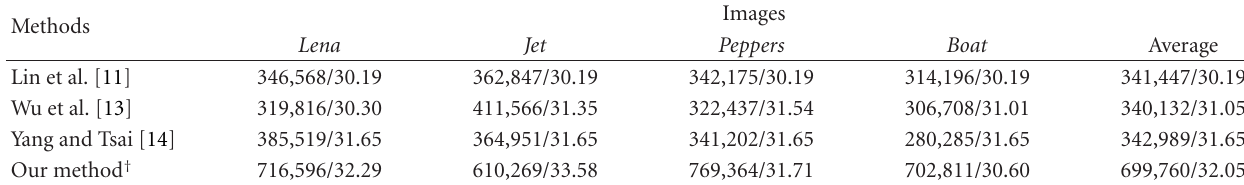
Table 2: Payload/PSNR performance comparison between various methods (under PSNR value above 30 dB).